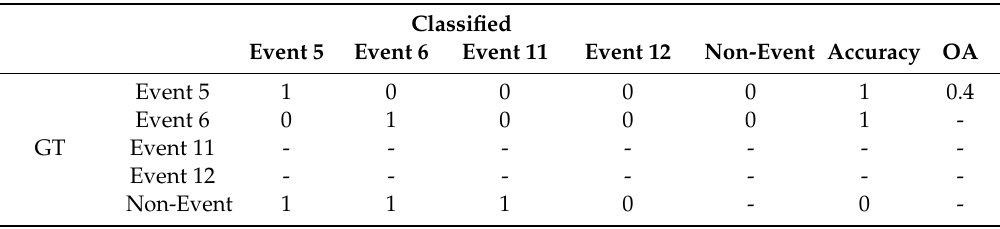
Event classification using the VideoGraph only approach for one VIRAT